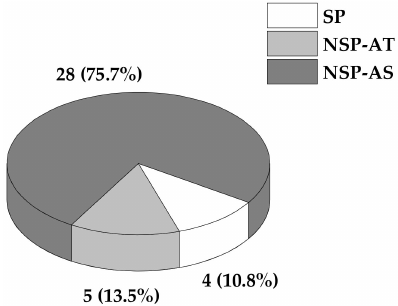
Figure 10. Cement production process facility types in South